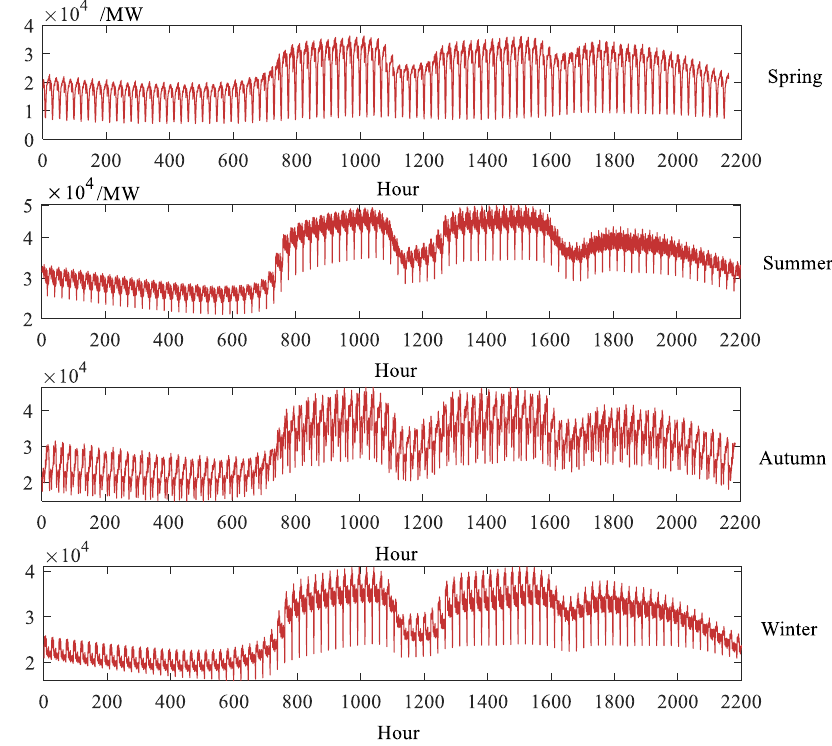
Figure 4. Hourly gas